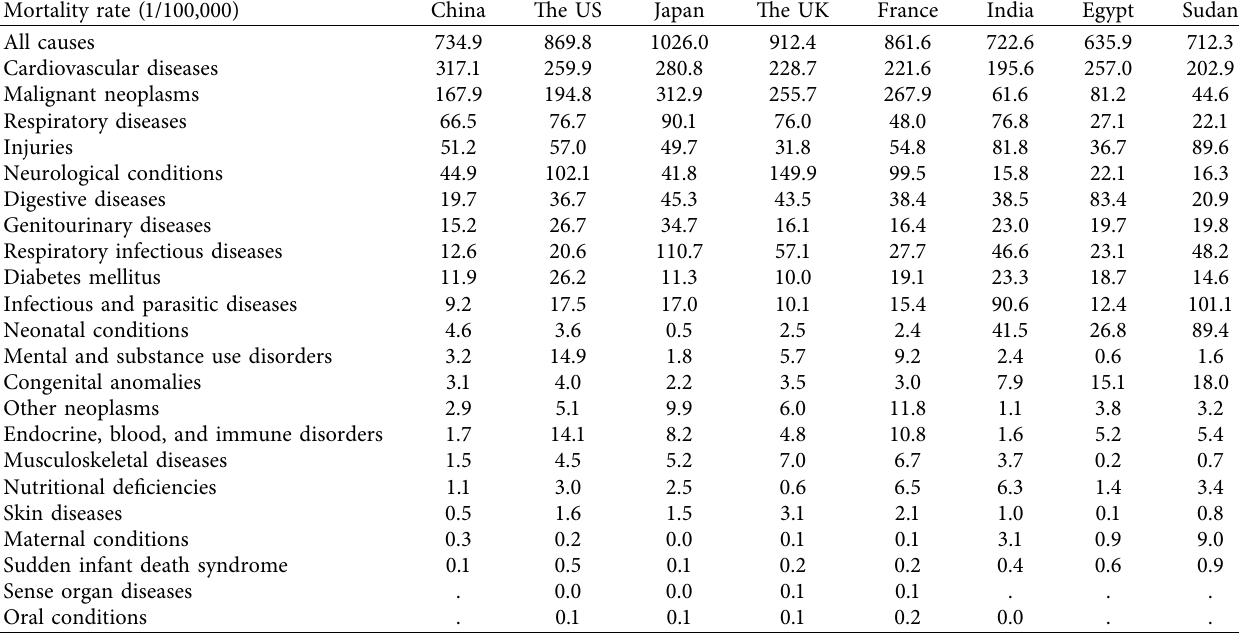
Maternal conditions Sudden infant death syndrome Sense organ diseases